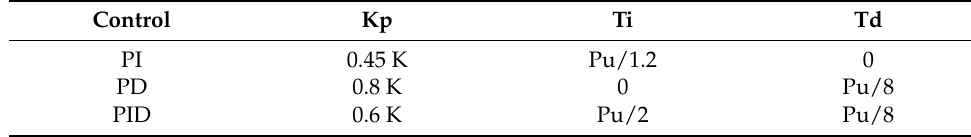
Table 2. Control parameters for secondary